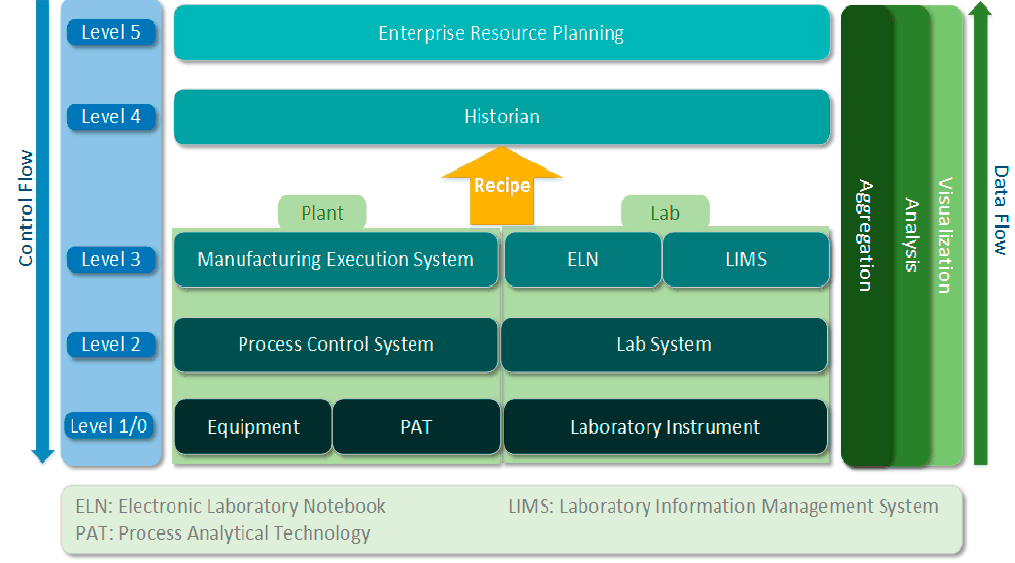
Figure 4. Architecture of data integration.